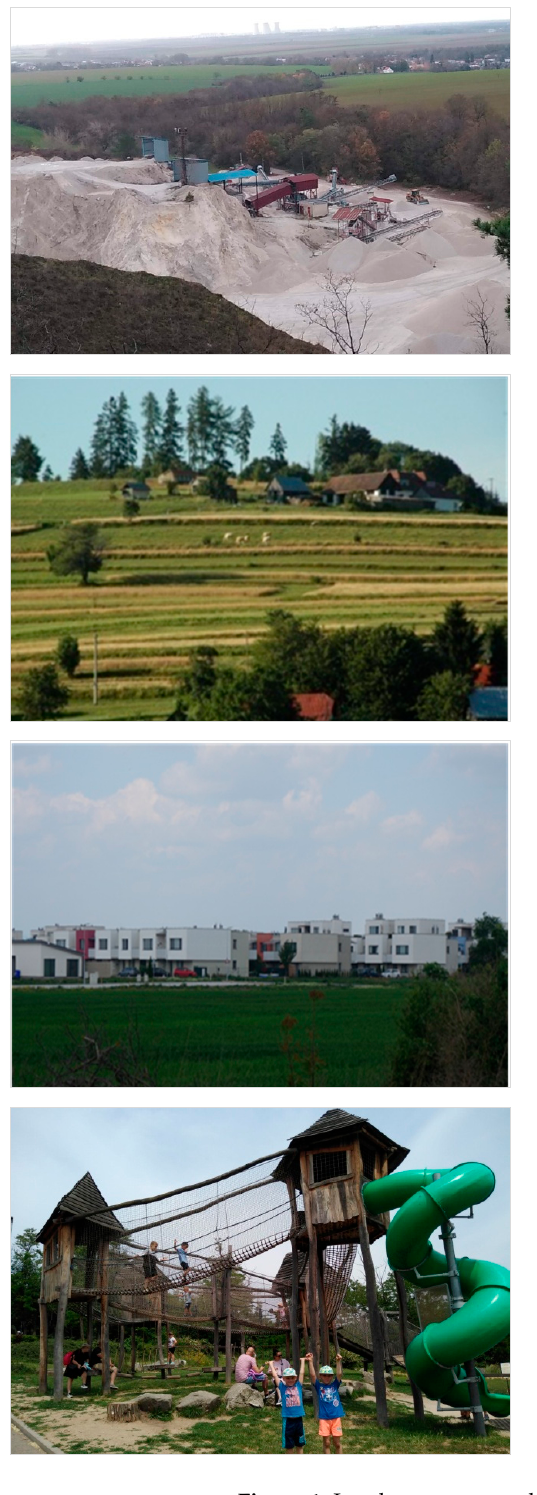
Figure 1. Landscape type and subtypes in Slovakia (Industrial mining landscape—Doln ý